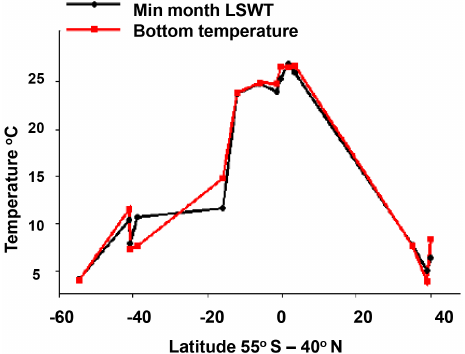
Figure 18. Comparison of lake-bottom temperatures during the stratification period, obtained from FLake model run using per- petual hydrological year, 2005/06 (Kirillin et al., 2011) and the monthly minimum climatology lake surface water temperature (LSWT) observations from ARC-Lake, for 14 deep ( > 25m) non- ice-covered lakes (55 ◦ S to 40 ◦ N). The monthly minimum observed LSWTs have a ∼ 1:1 relationship with the lake-bottom tempera- tures during the stratification